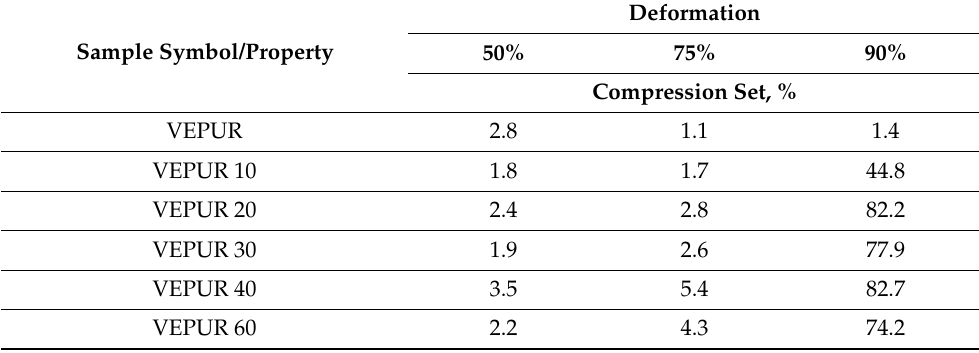
Table 10. Results of measurements of permanent deformation after compression of produced foams.